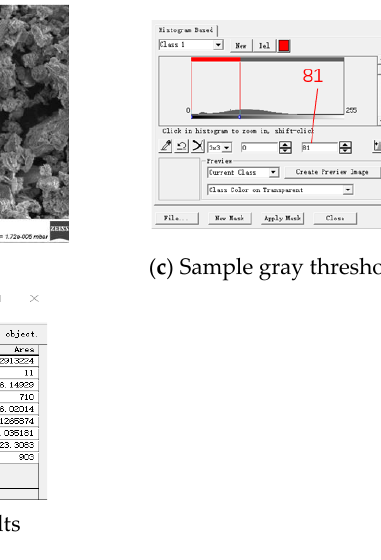
Figure 13. Process of porosity